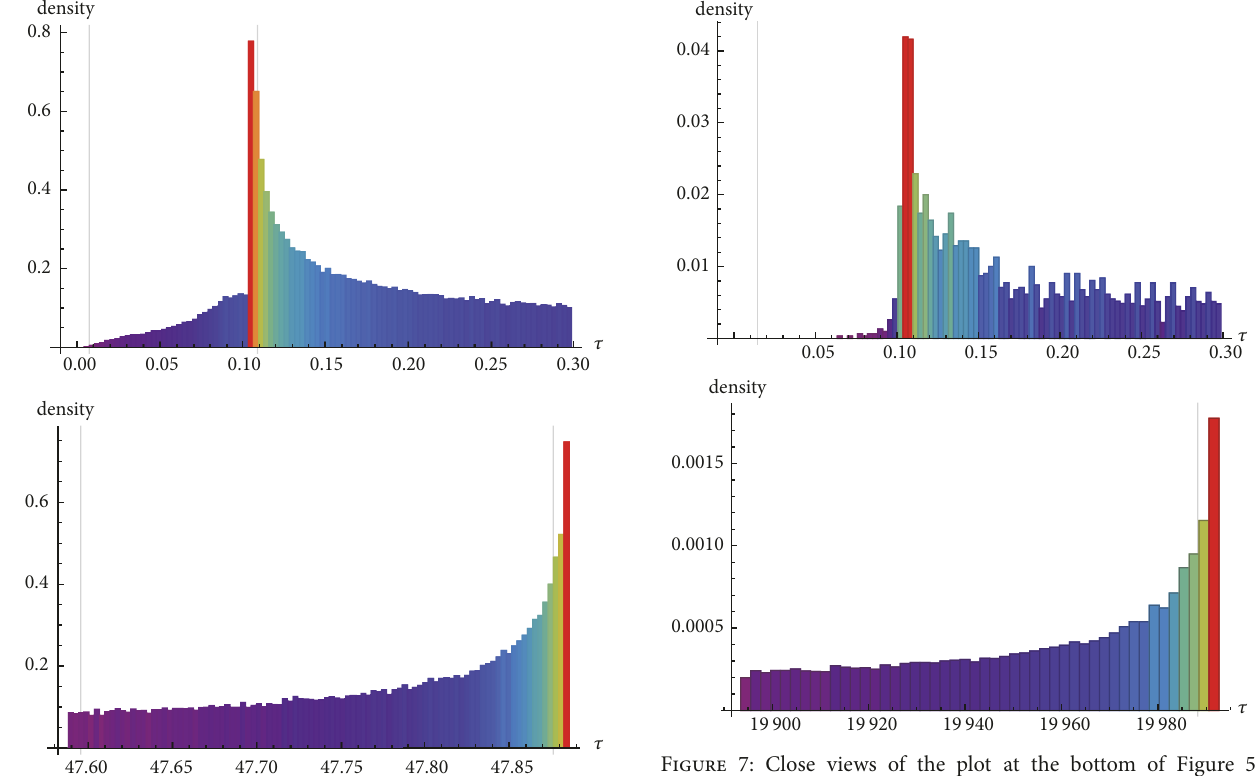
Figure 6: Close views of the plot at the top of Figure 5, correspond- ing to the barrier width 𝑏 − 𝑎 = 2 , with the bin length ≈ 0.0031𝑎.𝑢. ( ≈ 0.15 attoseconds). Top : small tunneling times. The vertical grey line in the left of this plot corresponds to the time the light takes to travelthe barrier distance. The second grey vertical line corresponds tothe percentile 1 %. Bottom: large tunnelingtimes. The vertical grey lines correspond to the percentiles 95 % and 99 %, respectively.